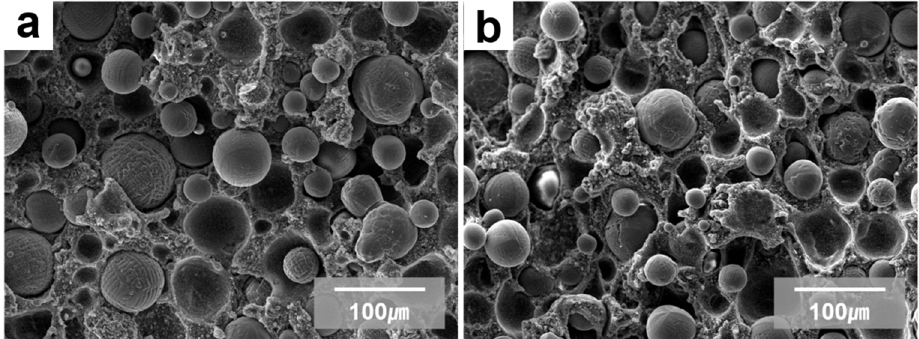
Figure 8. Cross-sectional SEM images of thermal pads using aluminum oxide and copper powder of ( a ) type B-Cu 10 and ( b ) type E-Cu 10.